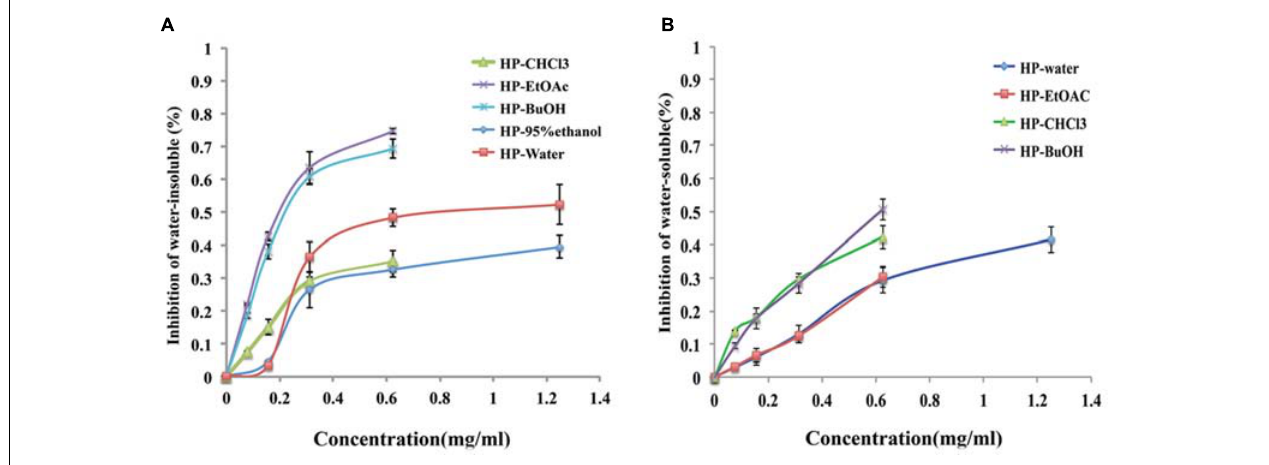
FIGURE 4 | Percent inhibition of extracts/sub-extracts effect on EPS glucans by the phenol/H 2 SO 4 method. (A) (%) Inhibition of water-insoluble glucans. (B) (%) Inhibition of water-soluble glucans. The extracts of B. crassifolia leaves were serially diluted twofold in BHI broth containing 1% sucrose from 1/8 MIC to MIC respectively. The graph represents the actual concentrations of the MIC dilutions. Data are presented as the mean ± standard deviation.